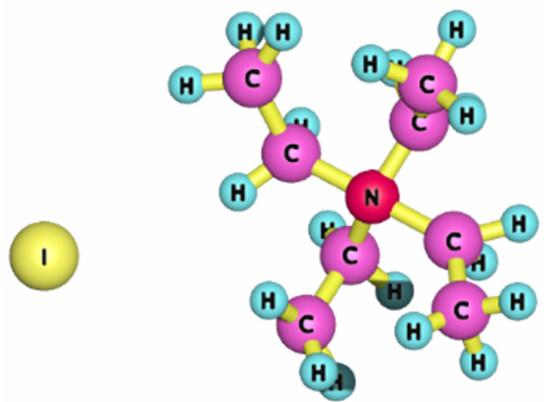
Figure 7. Three-dimensional structure of tetramethylammonium bromide (TMAB).